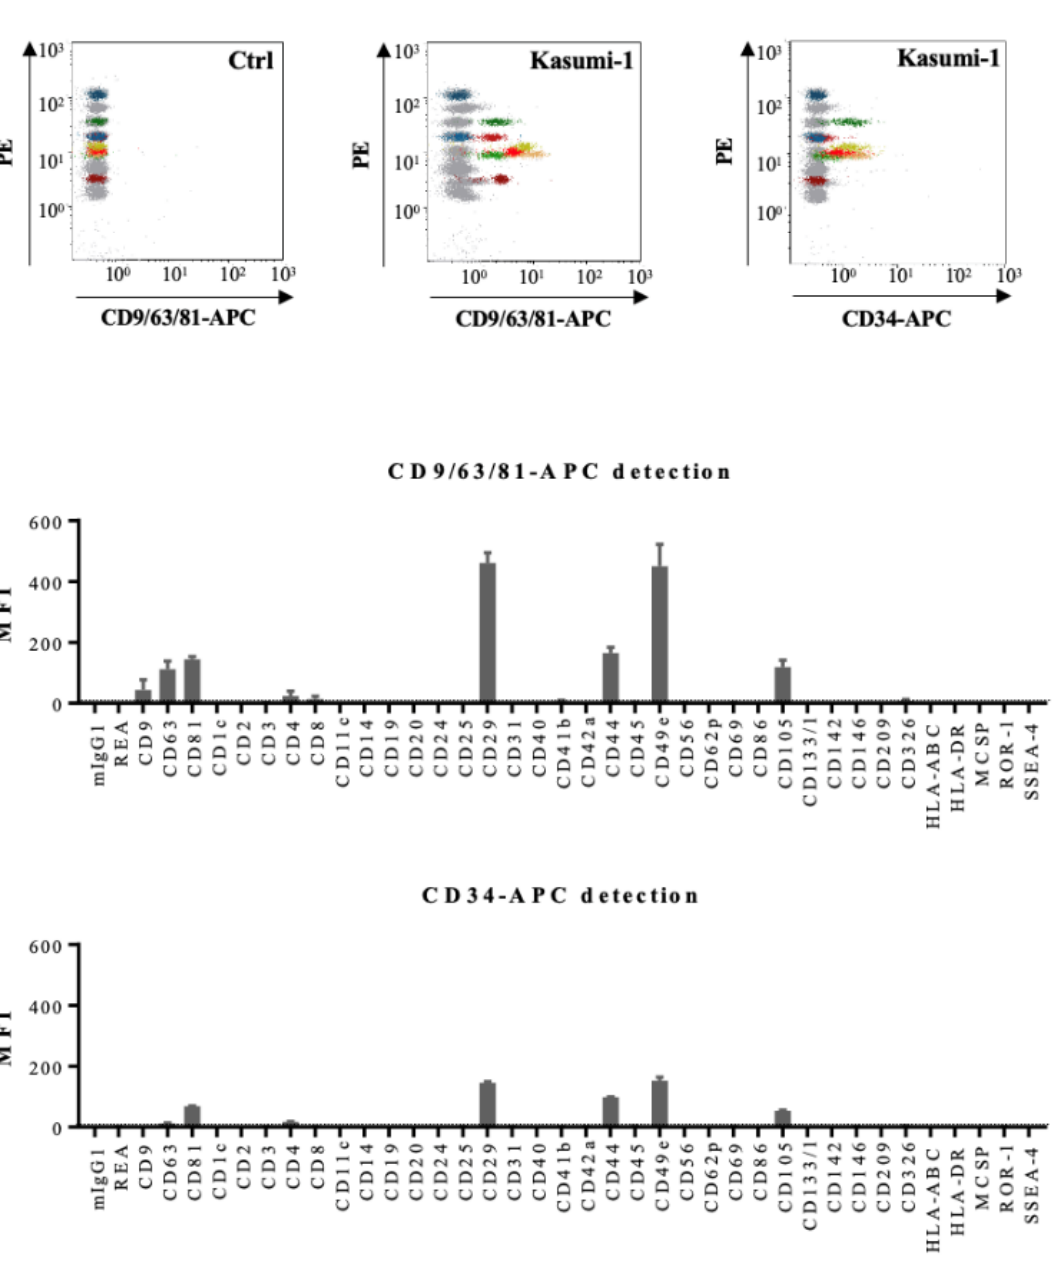
Figure 4. Multiplex bead-based flow cytometry assay: analysis of Kasumi-1 cell line. ( A ) Representative dot plots of multiplex bead-based flow cytometry analysis of Kasumi-1 CM-derived EVs showing measurements of single intensities of respective APC-stained bead populations, either anti- CD9/CD63/CD81-APC-stained (middle panel) or CD34-APC-stained (right panel) compared to the respective serum-free medium control values (Ctrl, left panel). ( B ) Median APC fluorescence intensities (MFI) for all 39 bead populations after background correction (serum-free medium values subtracted from measured Kasumi-1 CM values) with CD9/CD63/CD81-APC or CD34-APC detec- tion.